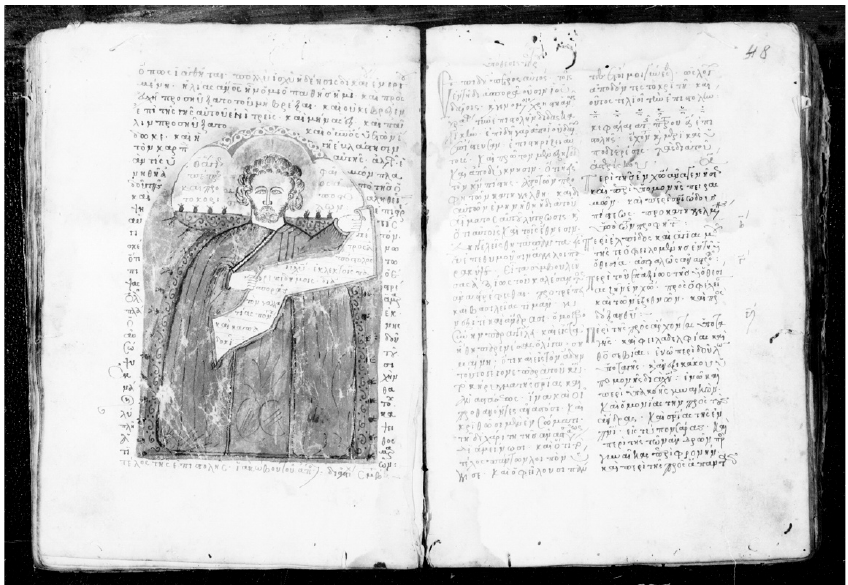
Figure 1. Image of the Apostle Peter. Monastery of the Lavra (Mount Athas) K.190. f. 47v (GA 1751). 1479 CE. Public domain image made available by the Library of Congress Collection of Manuscripts from the Monasteries of Mt.